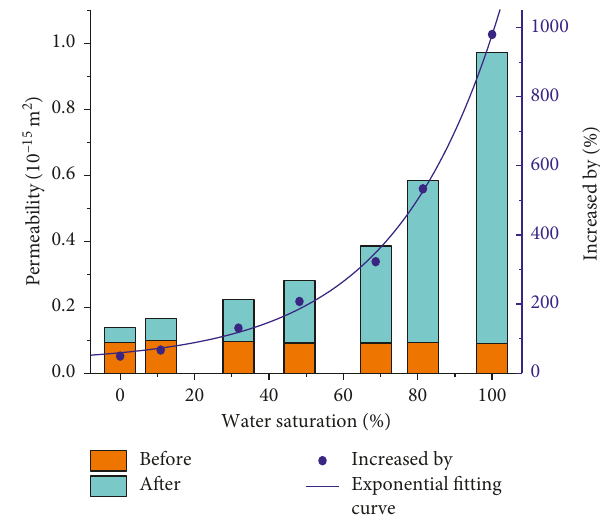
Figure 6: Changes in permeability with water